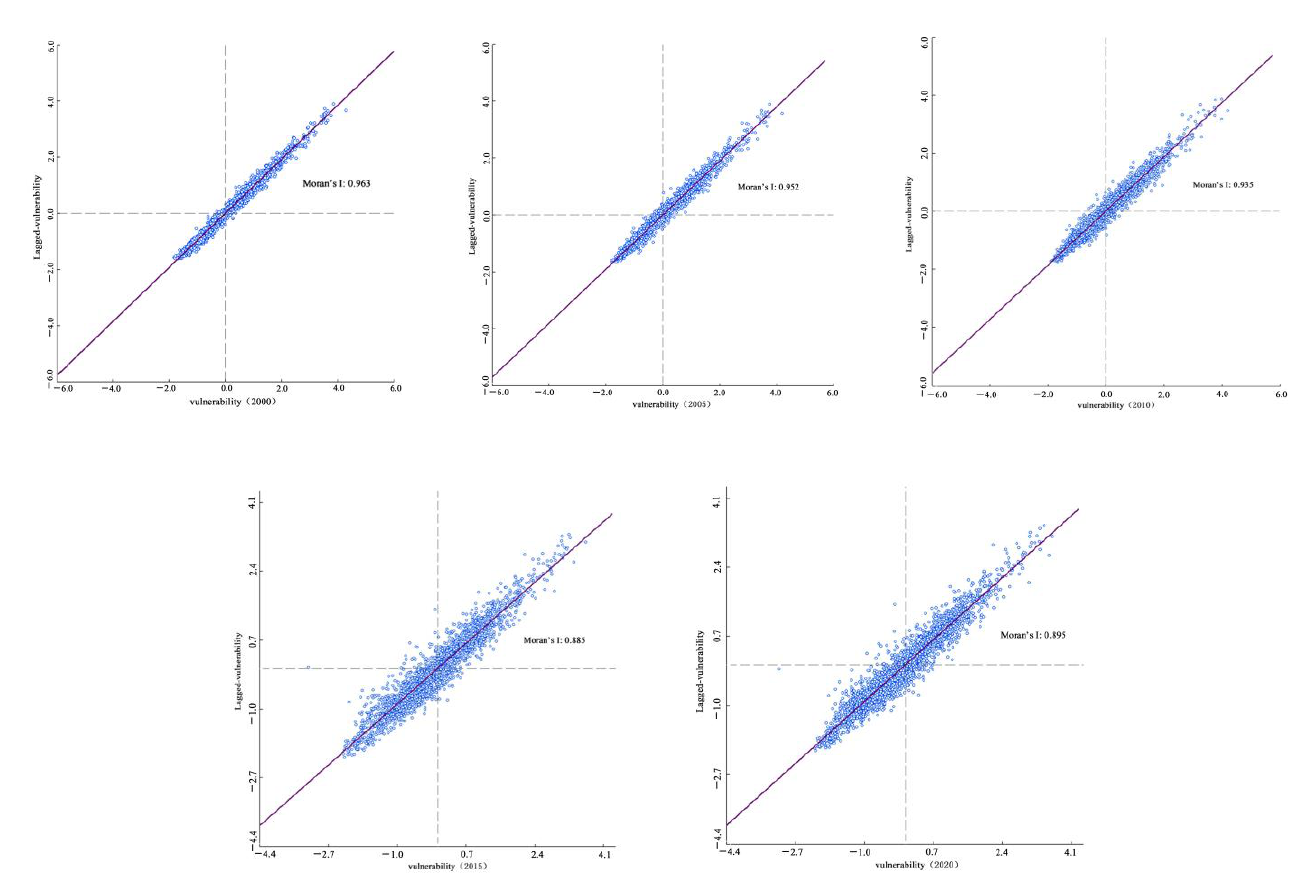
Figure 4. Global Moran’s I scatter plot of ecological vulnerability in red soil erosion area of Changting from 2000 to 2020. The x-axis represents the ecological vulnerability of each year, and the y-axis represents the spatial lag of the ecological vulnerability of each year. The farther the distance from the baseline, the stronger the spatial lag and the weaker the spatial agglomeration.